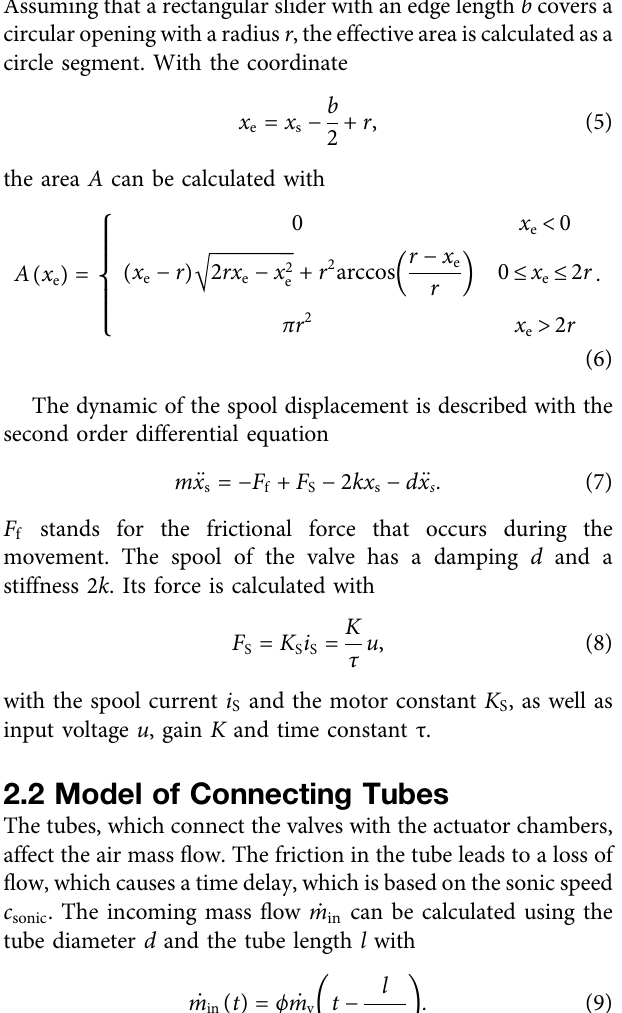
Frontiers in Robotics and AI |